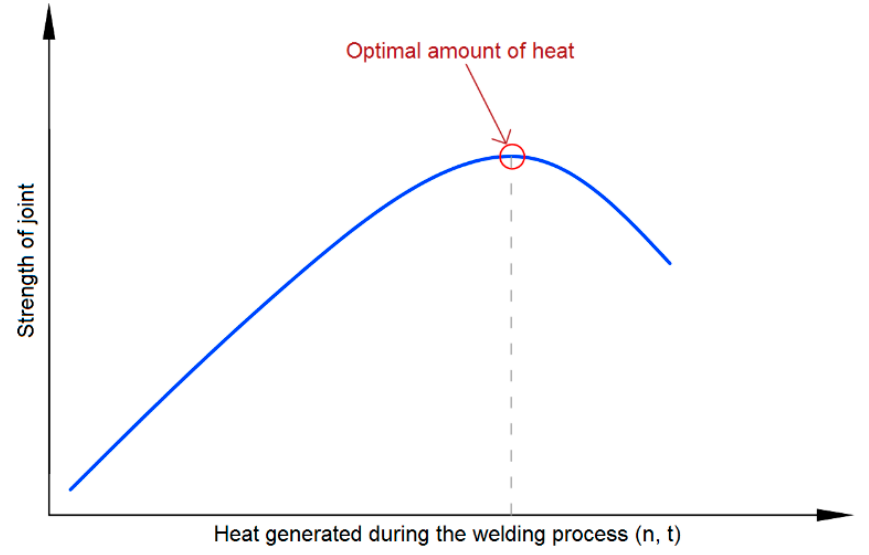
Figure 15. Illustrative diagram of the influence of the amount of heat generated during RFSSW on the strength of the joint.